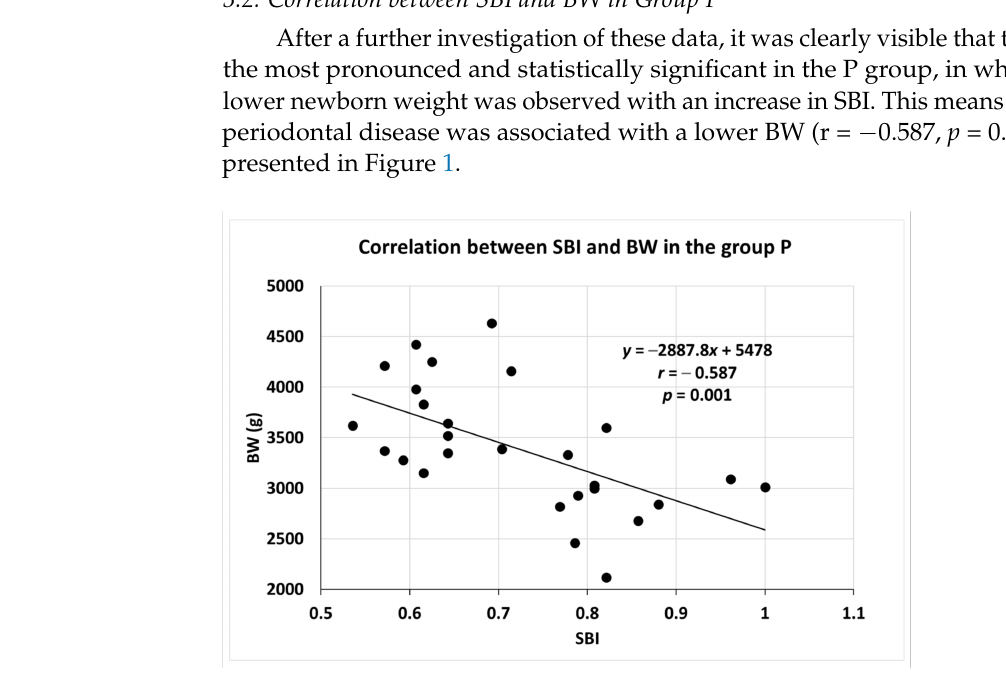
Figure 1. Correlation between SBI and BW in group P. Results are shown as means ( ± SD). BW = birth weight; SBI = sulcus bleeding index; P = periodontitis; n = 111; and p < 0.05 was considered statistically